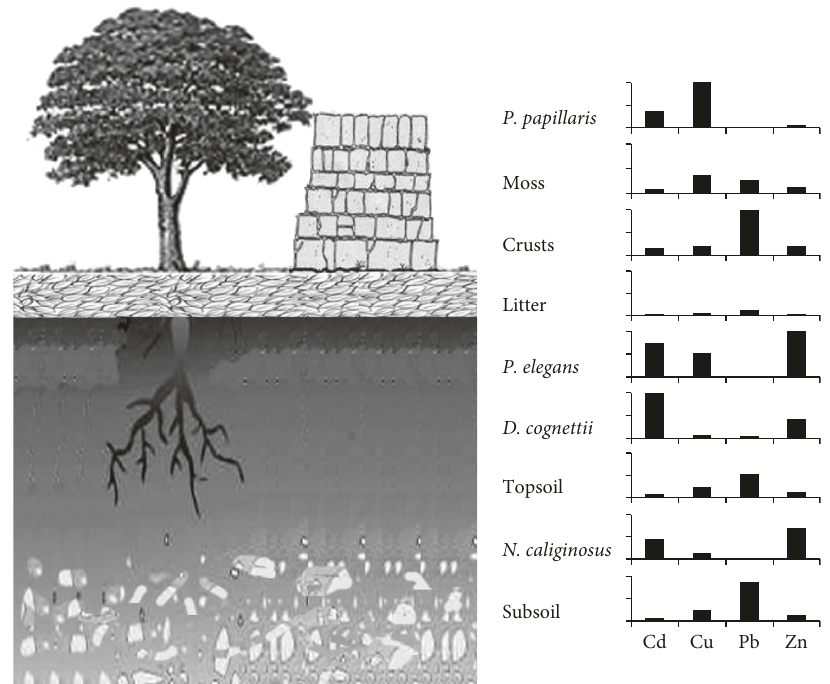
Figure 2: Comparisons between average Cd, Cu, Pb, and Zn concentrations in the different environmental matrices from the urban park and vegetated walls in Siena. Values are reported as % of the highest metal concentration in all matrices (all data sources as for Tables 1 and